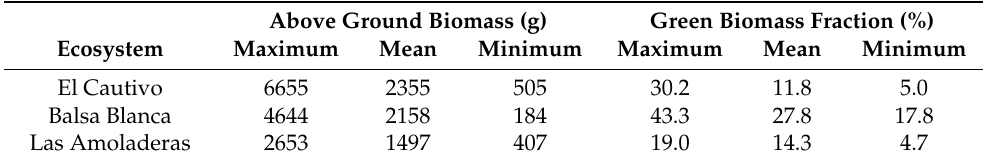
Table 1. Maximum, mean, and minimum values of total AGB (g) and GBF (%) for all plants in each of the three analysed ecosystems.